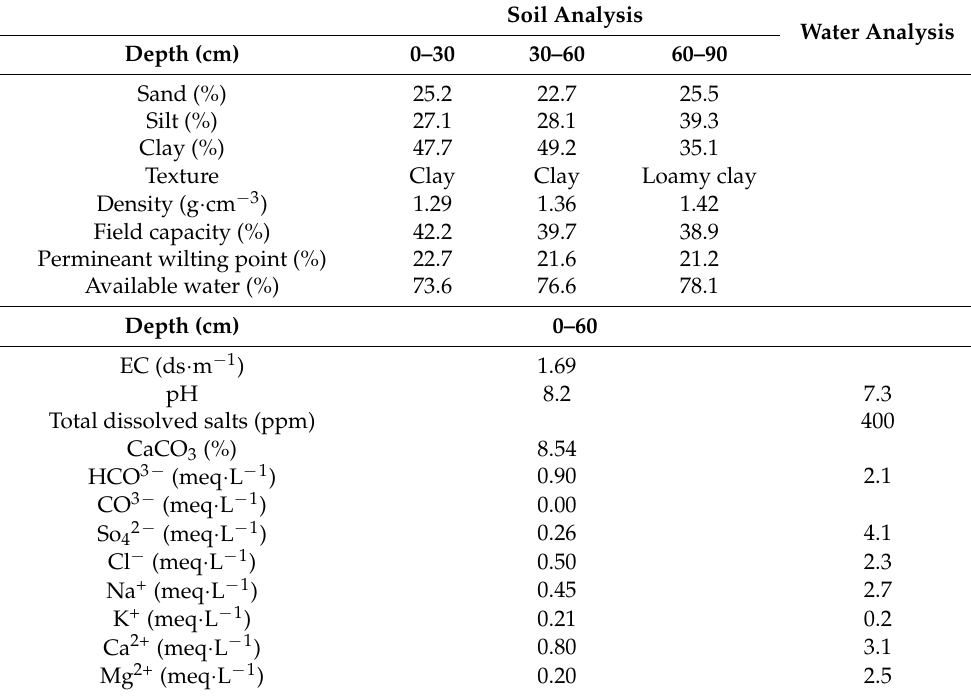
Table 2. Soil and water analysis of the experimental